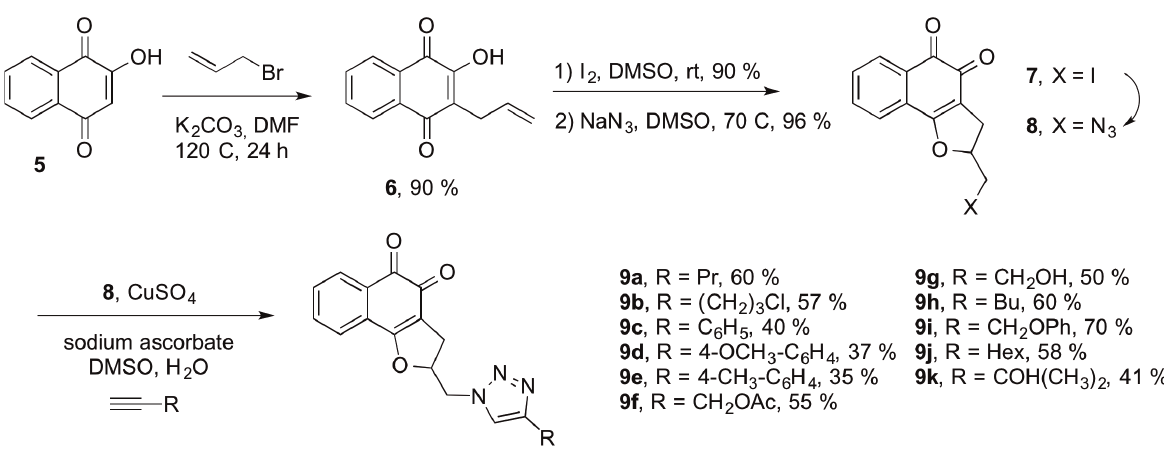
Figure 2 - Synthesis of 1 H -1,2,3-triazoles-linked to 2,3-dihydronaphtho[1,2- b